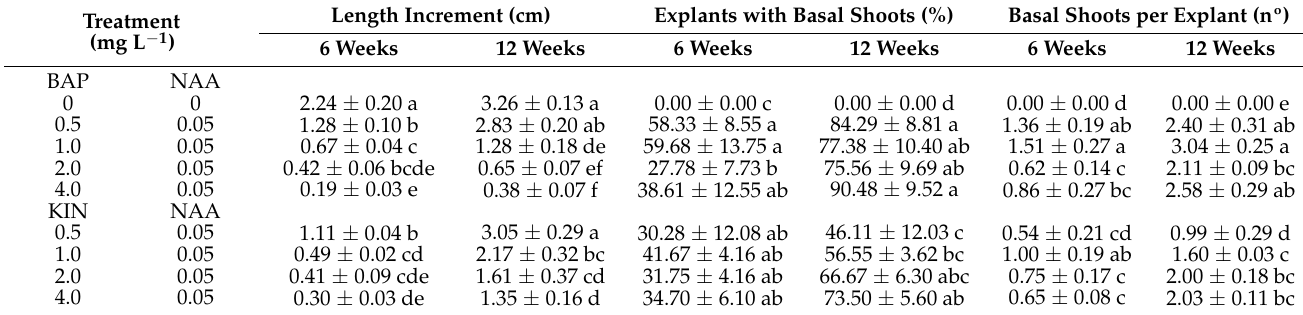
Table 2. Effect of nine combinations of BAP or KIN with 1-naphthaleneacetic acid (NAA) on Tetraclinis articulata (Vahl) Masters multiplication after 6 weeks of in vitro cultivation (mean ± SE) on SH medium (Schenk and Hildebrandt, 1972), and further culture in SH medium without PGRs for 6 more weeks. Mean values within a column, followed by the same letter are not significantly different by Dun-can’s multiple range test at the 95% level of